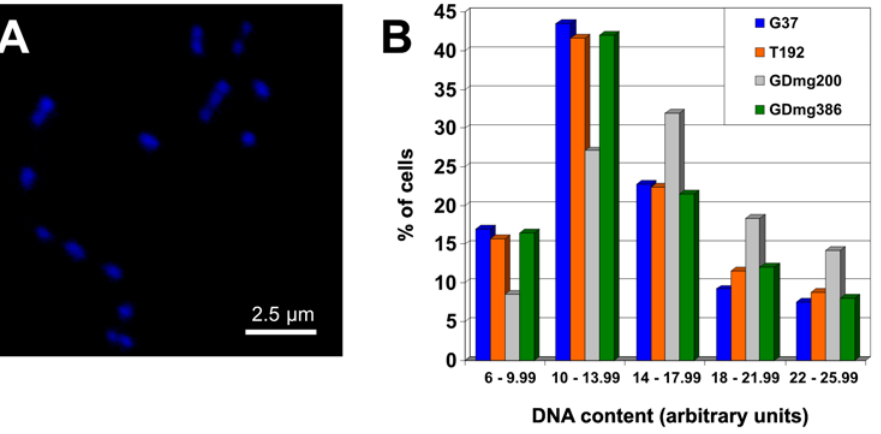
Figure 9. DNA content analysis. (A) Cells from the WT strain stained with DAPI. (B) Distribution of the DNA content per cell (DAPI mean density) of the WT strain, the T192 mutant, and the motility mutants GDmg200 c12 and GDmg386 c1.